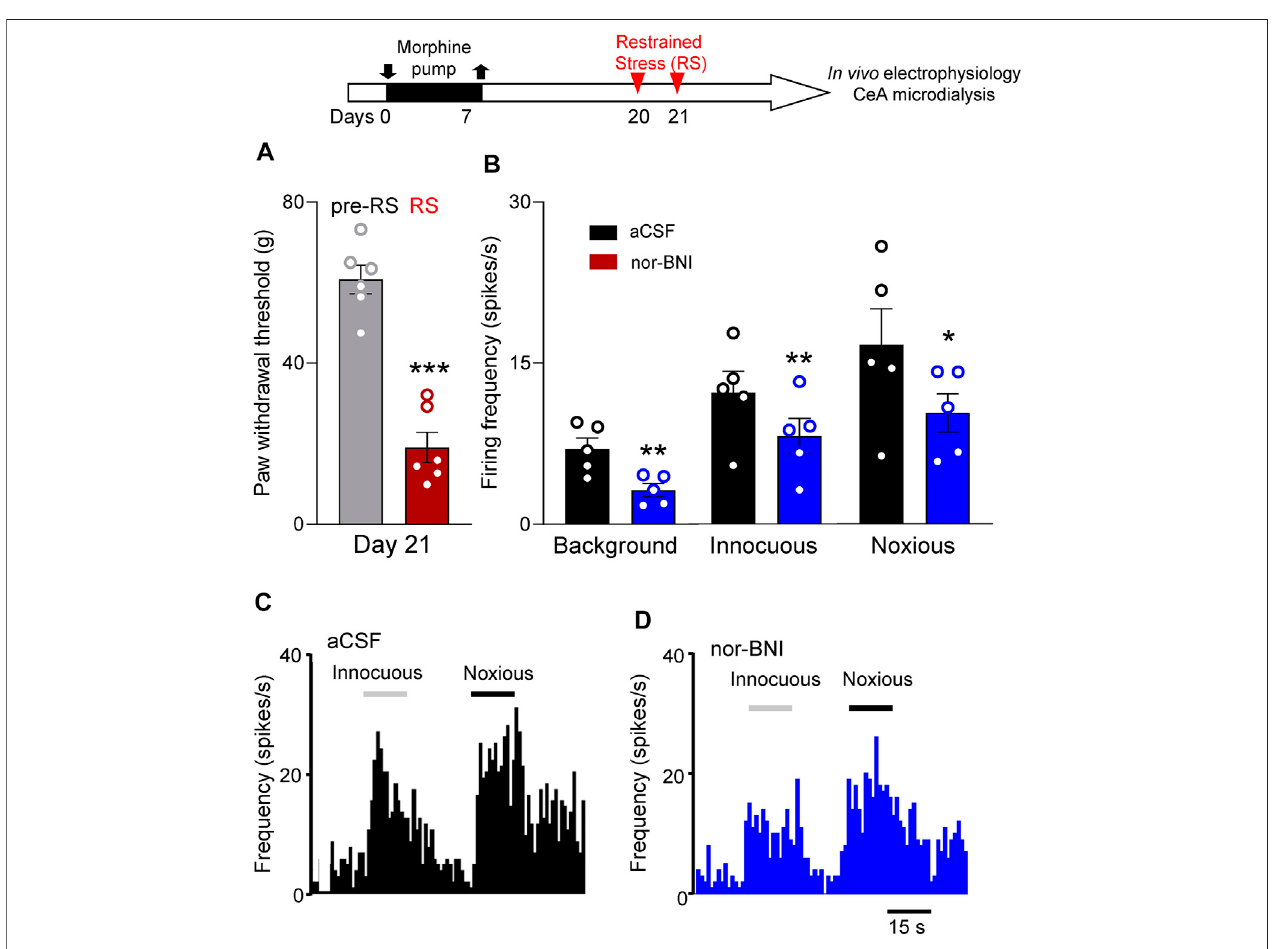
FIGURE5| Intra-amygdalarKORantagonistdecreasedactivityofCeAneuronsinafunctionalpainmodel.Timelineofexperimentalproceduresisshownatthetop ofFigure. (A) Restrainedstress(RS)decreasedpaw withdrawalthresholds(*** p < 0.001,paired t -test, n =6rats)measured withelectronicvonFreyinmorphine-primed rats used in the electrophysiology study (B – D) . (B) Administration of nor-BNI (100 μ M in microdialysis probe) into CeA decreased background activity (** p < 0.01, n = 5 neurons) of CeA neurons and responses to innocuous and noxious stimulations (*, ** p < 0.05, 0.01, n = 5 neurons) compared with predrug control values (aCSF). Bar histograms show means ± SEM. Symbols show values for individual rats (A) and neurons (B) .